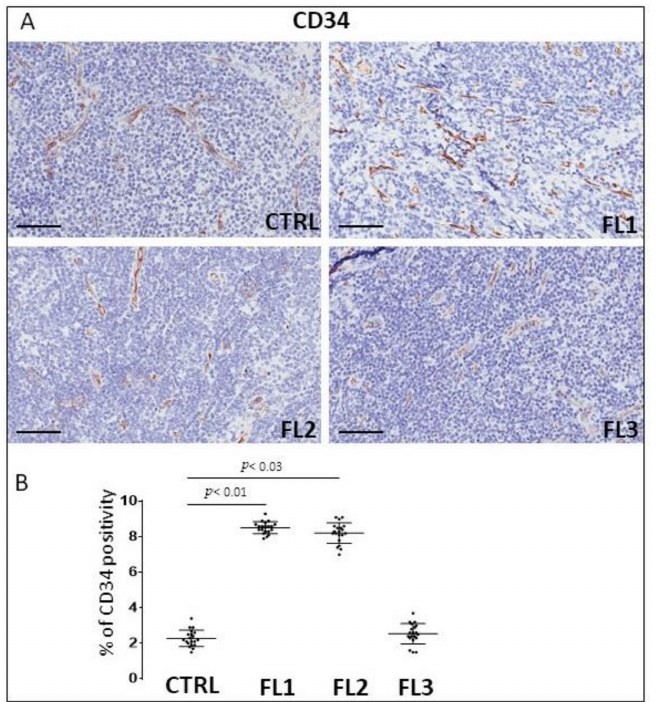
Figure 6. Immunohistochemical staining for CD34 in FL grade1 (FL1), FL grade2 (FL2), and FL grade 3 (FL3) and control samples (CTRL). Scale bar: 60 µ m ( A ). Morphometric analysis indicates the percentage of CD34 positivity in FL and CTRL samples ( B